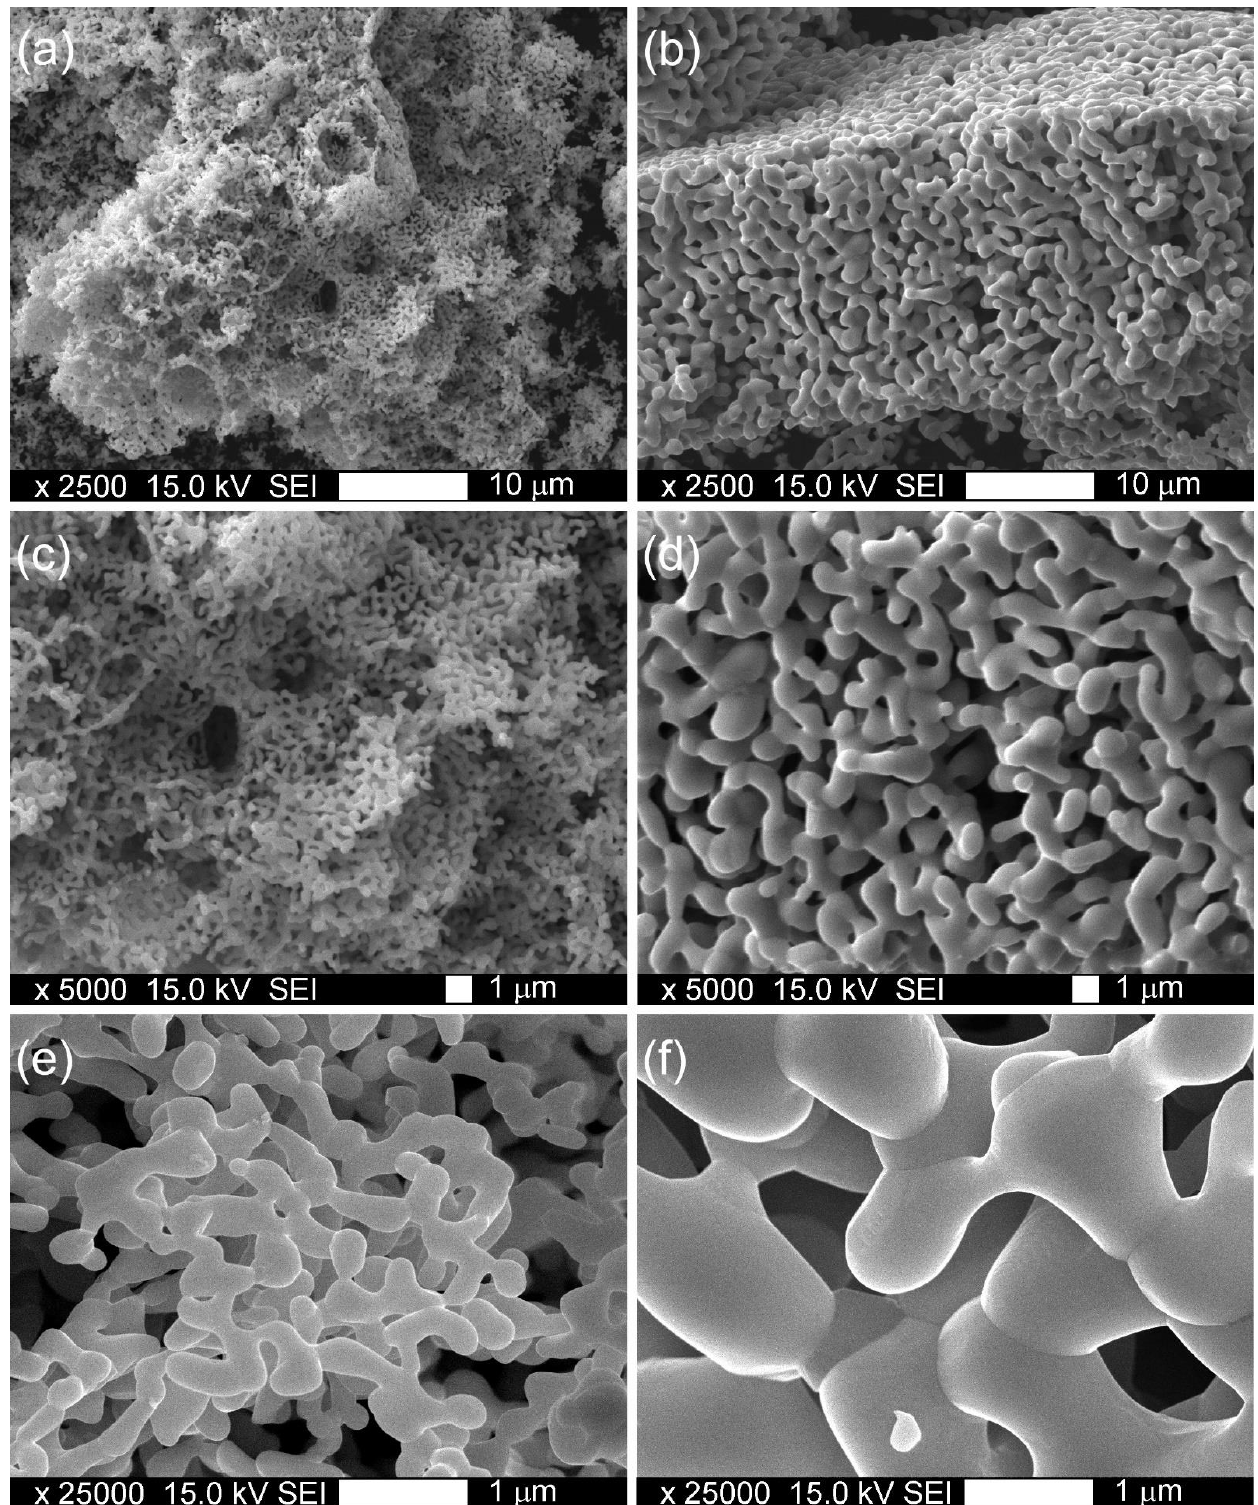
Figure 3. Morphology of YFC powders sintered at 950 °C ( a , c , e ) and 1100 °C ( b , d , f ). The morphology of the formed LSM1 composite cathode sintered at 1100 ◦ C is pre- sented in Figure 4. SEM images and point EDS analysis revealed a homogenous distribution of Y, Fe, and Co in the LSM matrix. Numerous pores of ~6 µ m in diameter originating from the thermal removal of polystyrene templates are observed in the microstructure